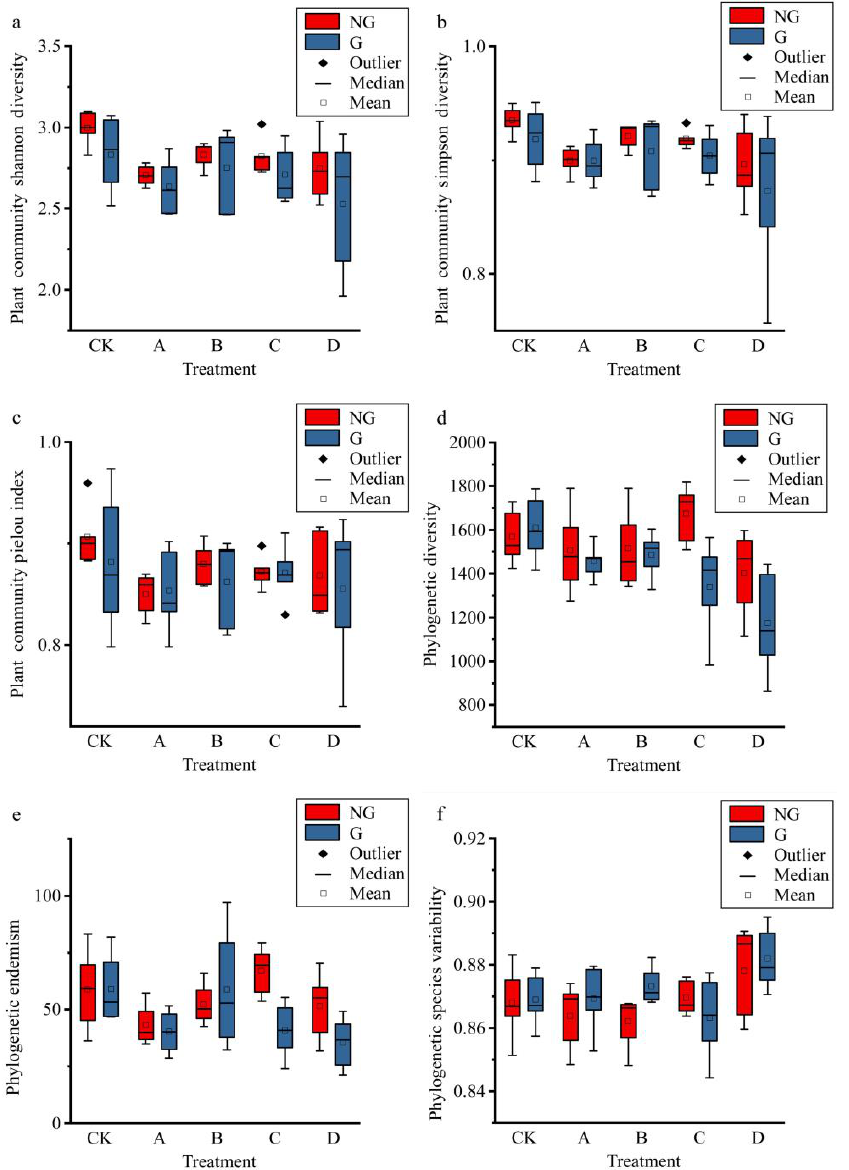
Figure 2. Effects of gradient warming and grazing on biodiversity of plant community. ( a ), plant community shannon diversity index; ( b ), plant community simpson diversity index; ( c ), plant commu- nity pielou diversity index; ( d ), plant community phylogenetic diversity index; ( e ), plant